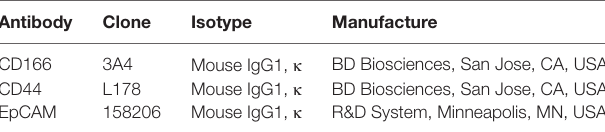
TaBle 1 | List of antibodies used in cancer stem cells